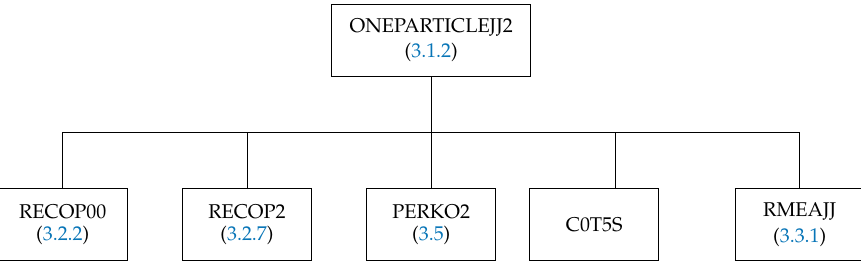
Figure 2. Structure of the subroutine ONEPARTICLEJJ2